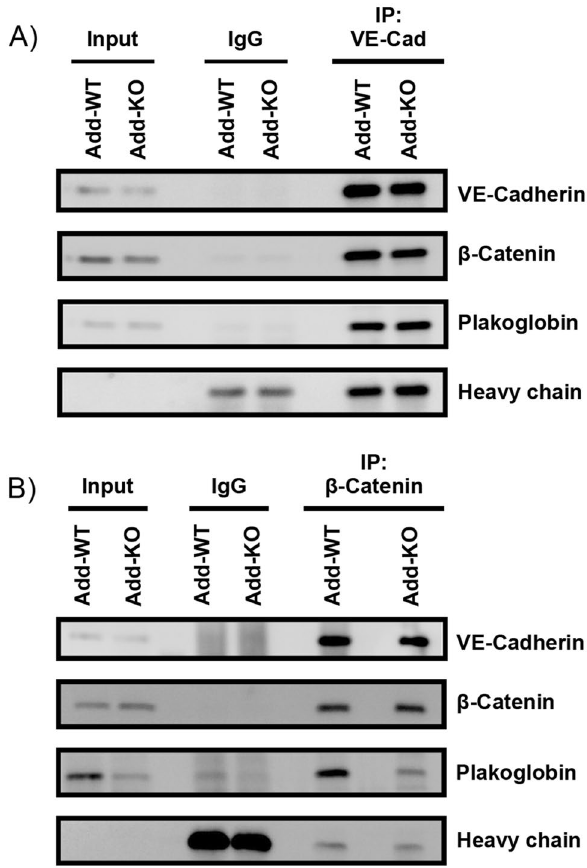
Figure 3. Analysis of the VE-Cadherin based complex by immunoprecipitation. Representative Western blots after ( A ) VE-Cadherin or ( B ) β-catenin pulldowns. Antibodies against VE-cadherin, ß-catenin and plakoglobin were used to asses co-immunoprecipitation partners after Add knock-out. Cell lysates were incubated with only beads and a species-specific anti-goat or anti-mouse IgG as negative controls, respectively. As input, total cell lysates before immunoprecipitation were loaded in the first and second lanes (N = 3 per